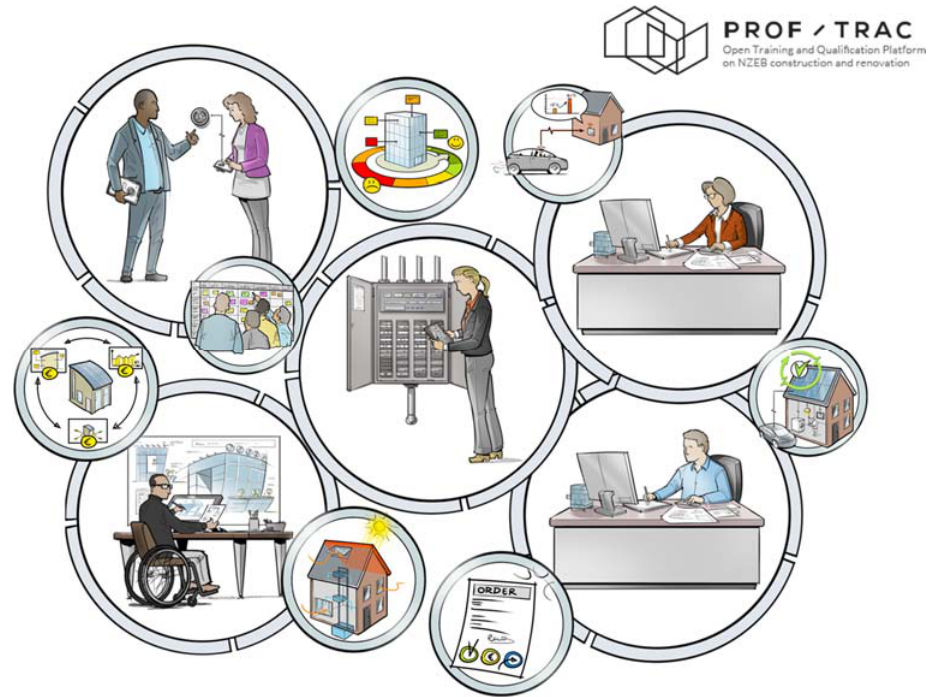
Figure 1. Visualizations of professions and technologies involved developed for the BUILD UP Skills Advisor